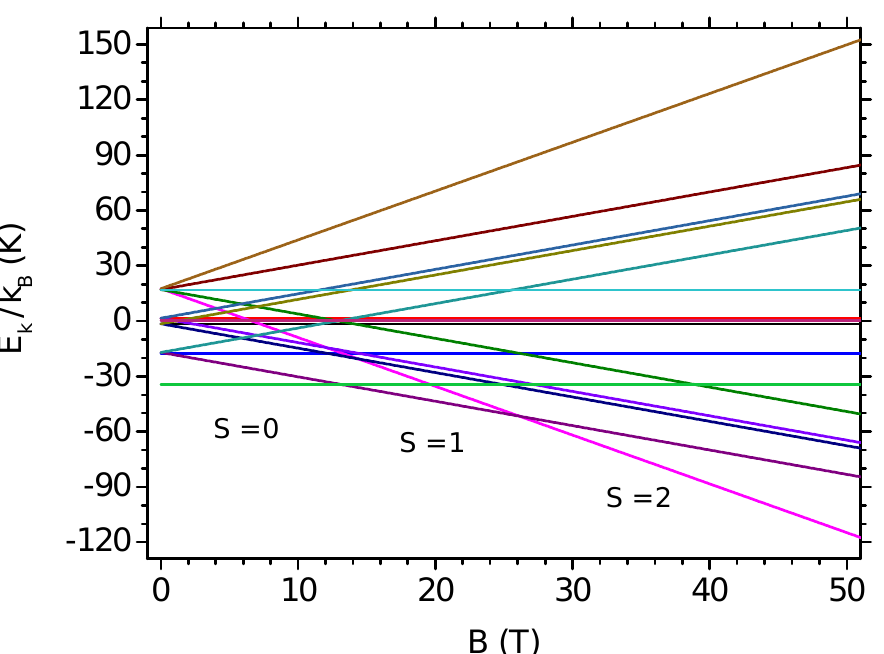
Figure 2. The dependence of the normalized eigenenergies of the tetramer Hamiltonian on the external magnetic field. The values of ground-state spin, S = 0,1,2 are marked below the ground